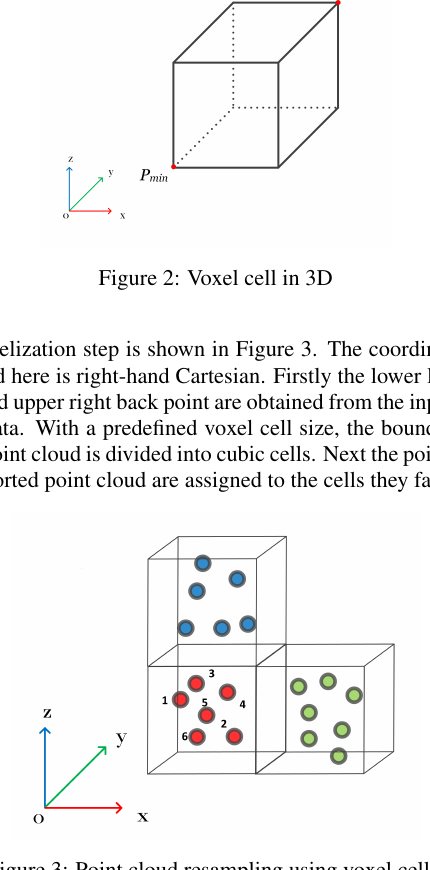
Figure 3: Point cloud resampling using voxel